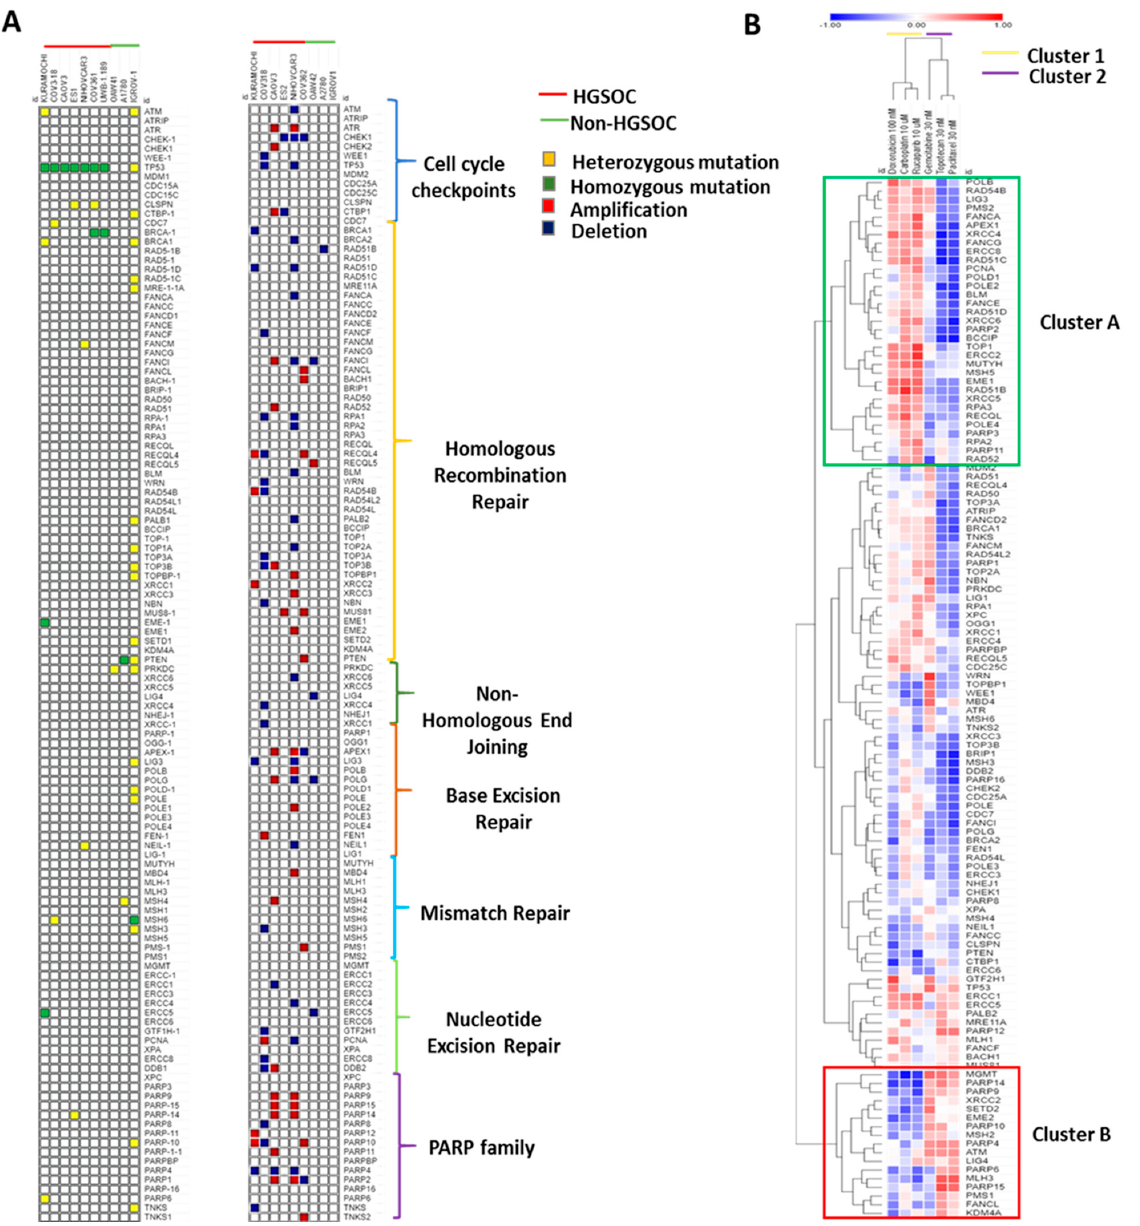
Figure 3. Genomic and transcriptomic alterations in the DNA damage repair (DDR) pathway determine response to chemotherapy in ovarian cancer cells ( A ) Mutation and copy number alteration profile of 120 DDR-regulatory genes among HGS and Non-HGSOC cell lines and the corresponding DDR pathways, ( B ) Hierarchical clustering of the Pearson’s correlation coefficient obtained by correlating gene expression values with the % survival of the cell lines at fixed concentrations of the drugs (shown in the figure). (Genome sequence data were available for 10/14 cell lines in the panel. Copy Number Analysis and RNA-Seq data for UWB1.289 cell line were not available).